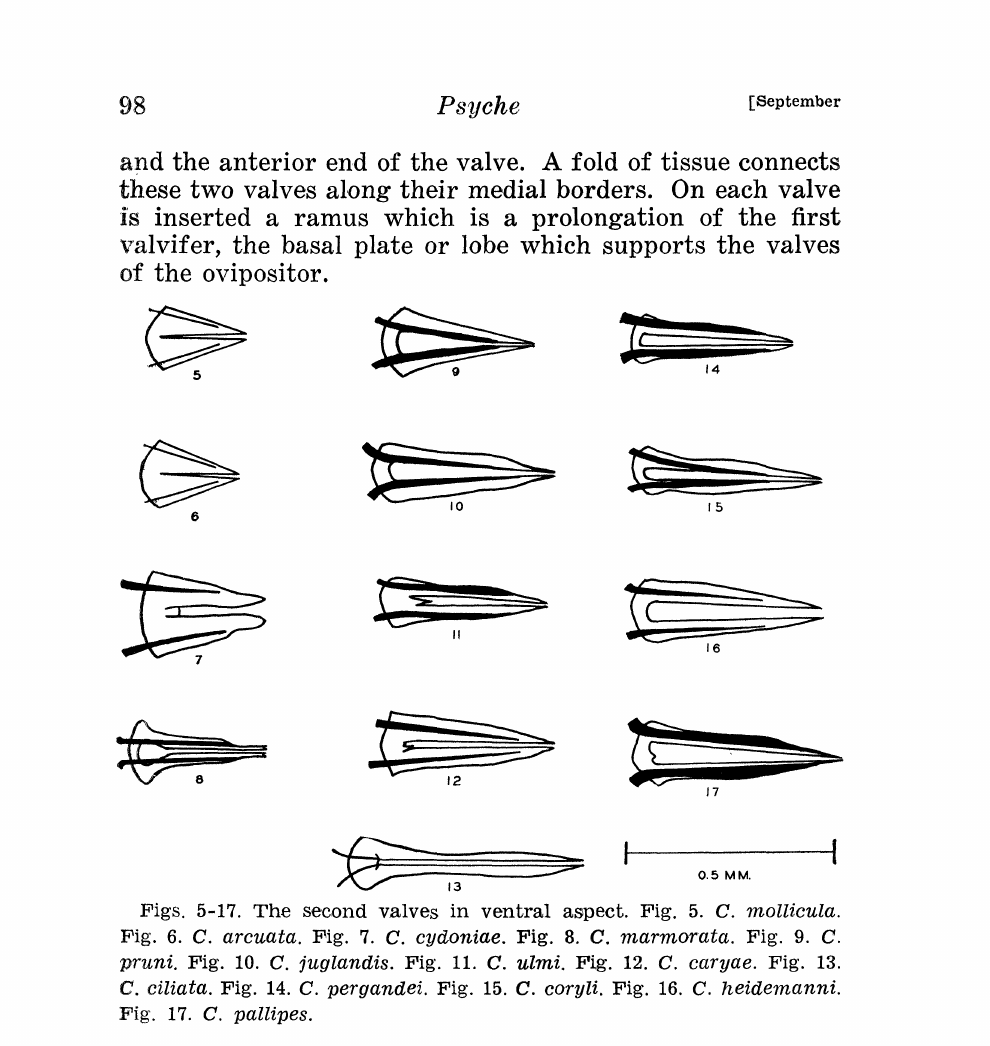
Figs. 5-17. The second valves in ventral aspect, tig. 5. C. molIicula. Fig. 6. C. arcuata, tig. 7. C. cydoniae. Fig. 8. Co marmorata. Fig. 9. C. pruni. Iig. 10. C. jugIandis, lig. 11. C. ulmi, tg. 12. C. caryae. Fig. 13. C. ciliata. Fig. 14. C. pergandei. Fig. 15. C. coryli. Fig. 16. C. heidemanni. Fig. 17. C.